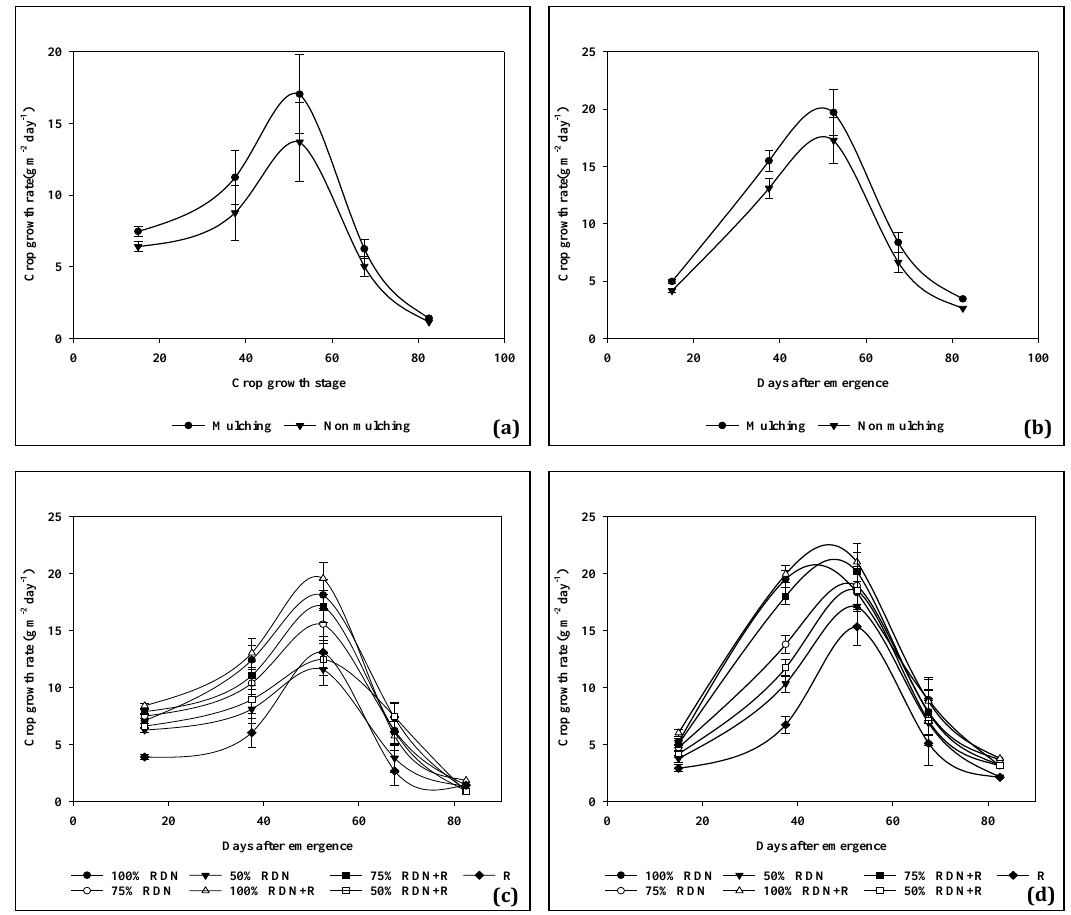
Figure 5. Effect of soil mulch ( a , b ) and nutrient management ( c , d ) on peanut crop growth rate at different growth stages (data from 2015–2016 and 2016–2017 crop seasons, respectively). Error bars represent the least significant difference values.